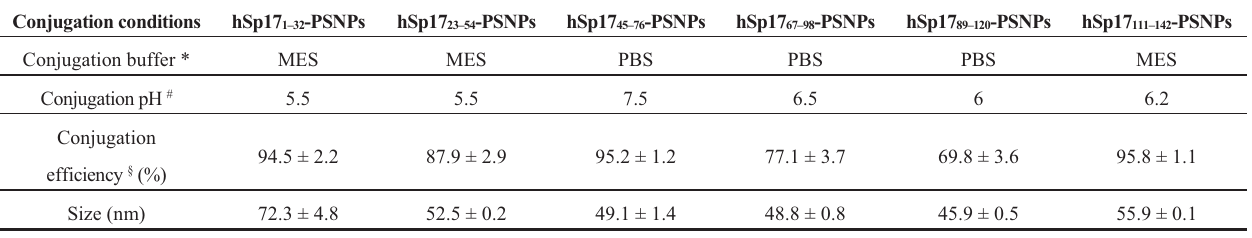
Table 1. Optimised conjugation conditions, efficiency and size of the hSp17 peptides-PSNPs